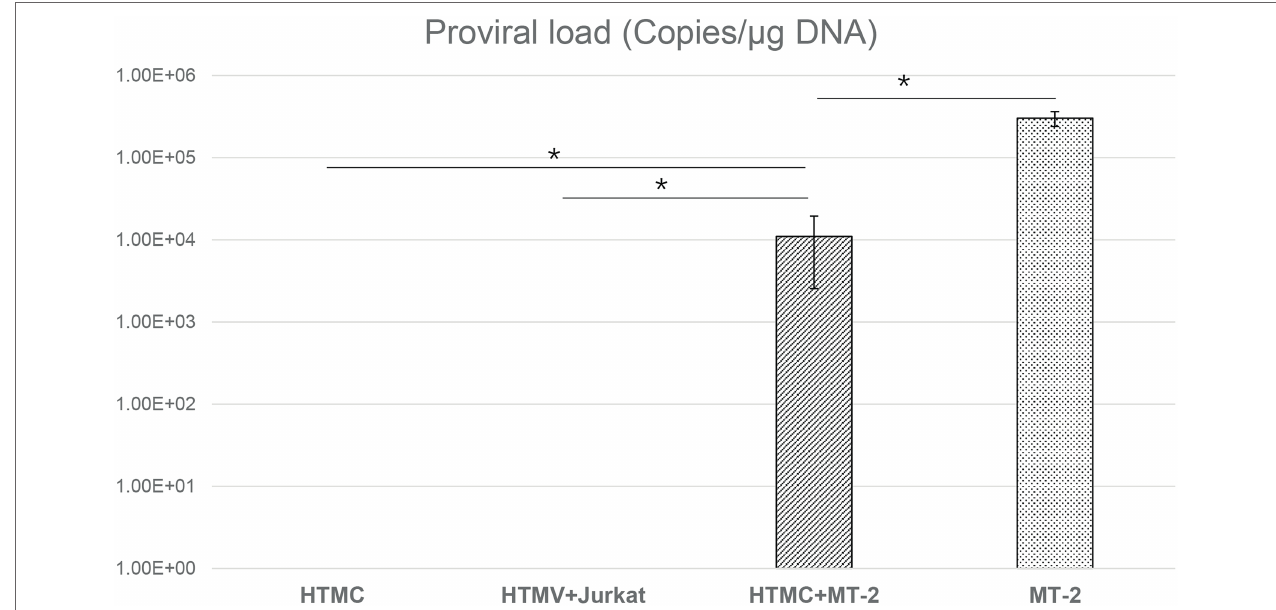
FIGURE 1 | Detection of HTLV-1 proviral DNA by RT-PCR in HTMCs transferred three times after co-culture with MT-2 cells, Jurkat cells, or culture alone. The number of each respective cell type was 1 × 10 5 . The same number of MT-2 cells was used as a positive control. Data are taken from three independent biological experiments. Error bars represent standard deviation (* p < 0.05; n.s., not